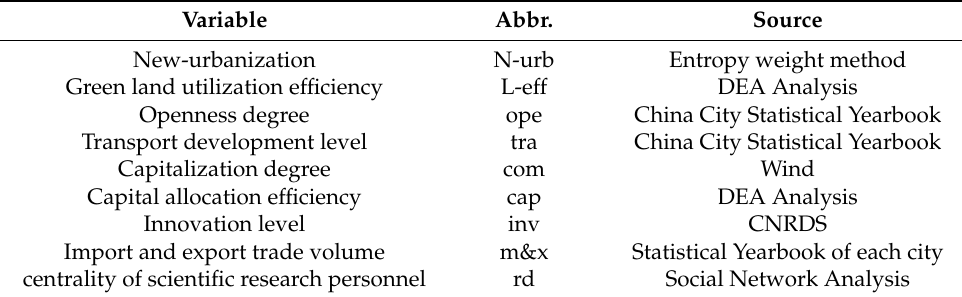
Table 3. Variable data sources.